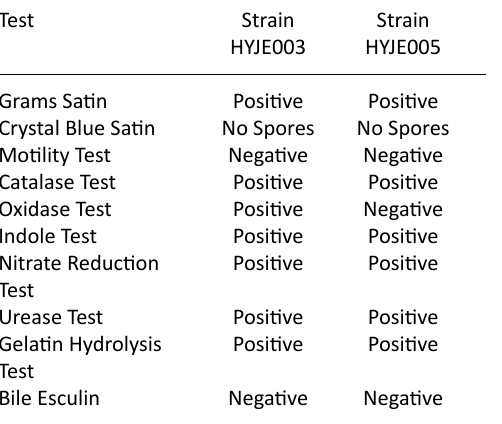
Table 2. Biochemical result of the isolated